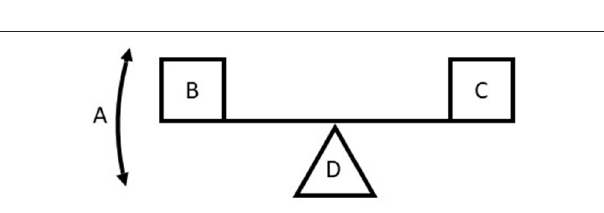
FIGURE 2 | Seesaw representing a trade-off situation. When A changes, B improves, and C becomes worse for example from an evolutionary perspective, or vice versa. The fulcrum, D, is assumed to not change, normally gains less attention, as our mind easily focuses on only the moving parts. This is a problem, as D influences how B and C depend on